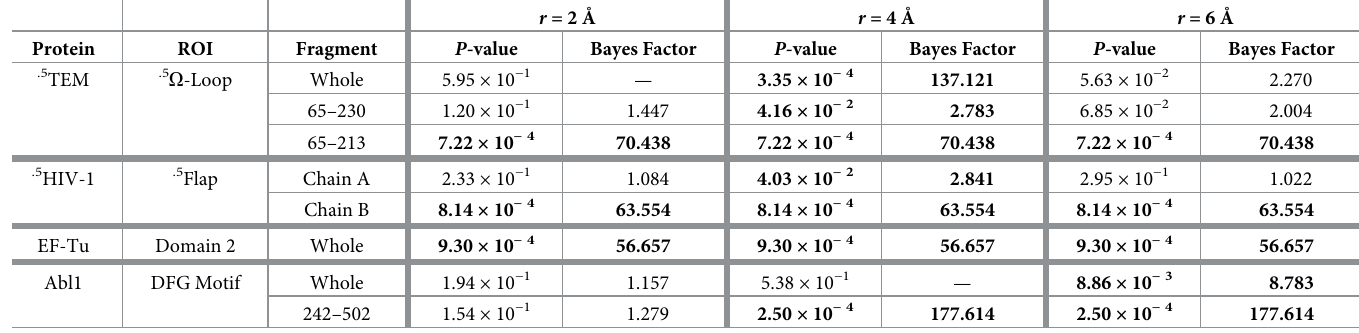
Table 3. Null hypothesis experiment to evaluate SINATRA Pro’s ability to find regions of interest (ROI) in each of the proteins analyzed in this study. Here, we assess how likely it is that SINATRA Pro finds the region of interest (ROI) by chance. These ROIs include: (i) the O -loop (residues 163–178) in TEM; (ii) the flap region (residues 47–55) in HIV-1 protease; (iii) Domain 2 (residues 208–308) in EF-Tu; and (iv) the DFG motif (residues 381–383) in Abl1. Note that protein structures were only analyzed if they contained an entire ROI. For example, in the context of Importin- β , the superhelix includes the entire structure and so we do conduct a null analysis. In this experiment, to produce the results above, we generate “null” regions on each protein using a K -nearest neighbors (KNN) algorithm on different atoms as random seeds [84], and exclude any generated regions that overlap with the ROI. Next, for each region, we sum the association metrics of all its atoms. We compare how many times the aggregate scores for the ROI are higher than those for the null regions. These “ P -values,” and their corresponding calibrated Bayes factors (BF) when the com- puted P < 1/ e , are provided above. Note that P -values less than the nominal size 0.05 and BFs greater than 2.456 are in bold. Results above are based on SINATRA Pro using parameters { c = 20, d = 8, θ = 0.80, l = 120} while varying the radius cutoff parameter r for mesh construction on each protein